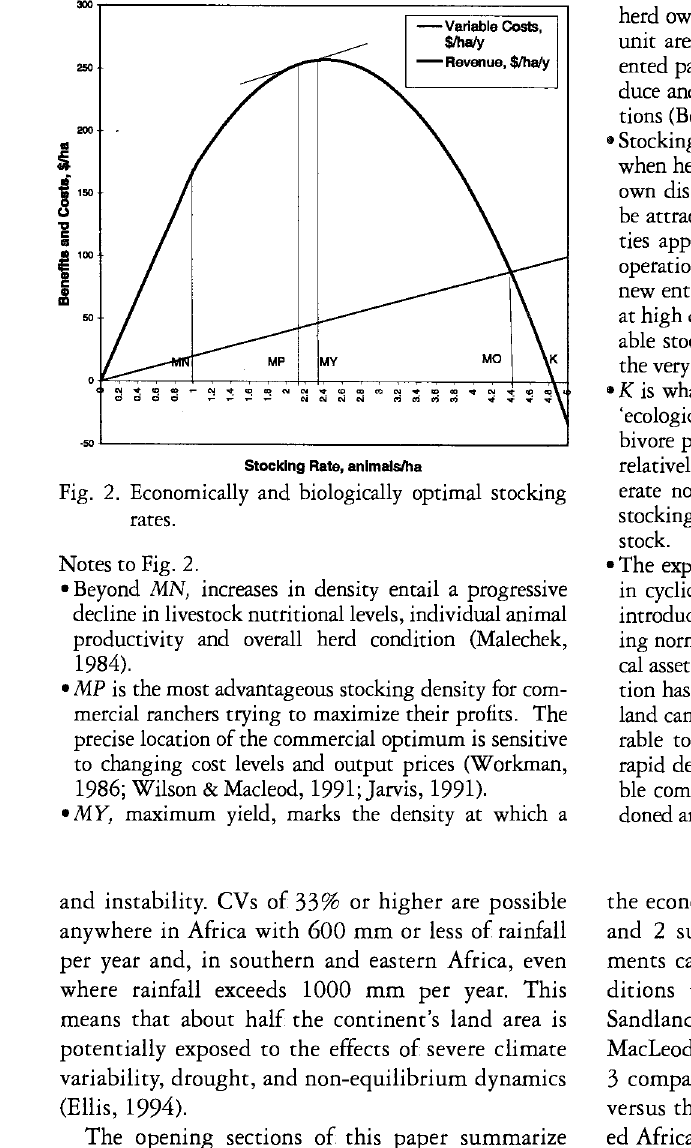
Fig. 2. Economically and biologically optimal stocking